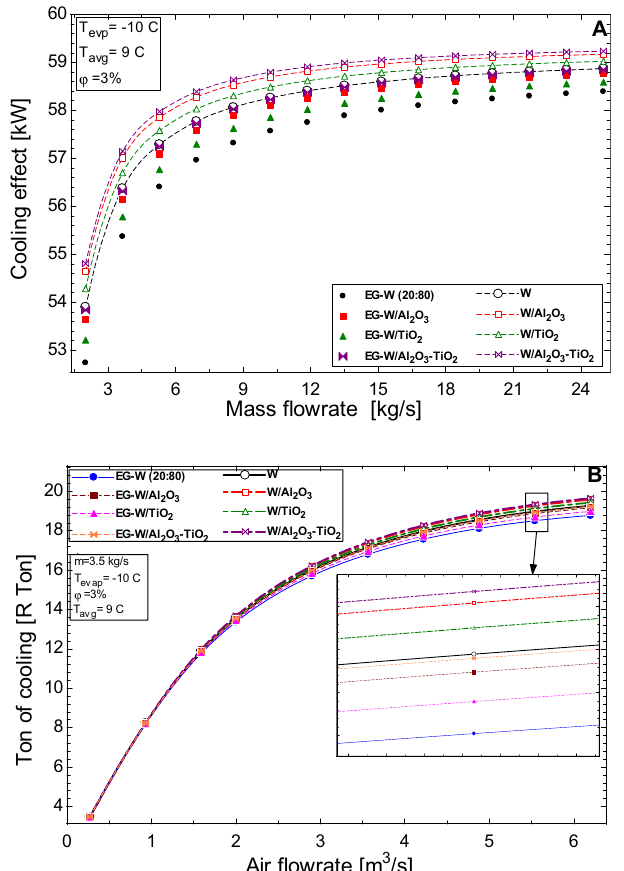
Figure 6. Effect of ( A ) mass flow rate of working fluids and ( B ) air flow rate on the cooling effect of the